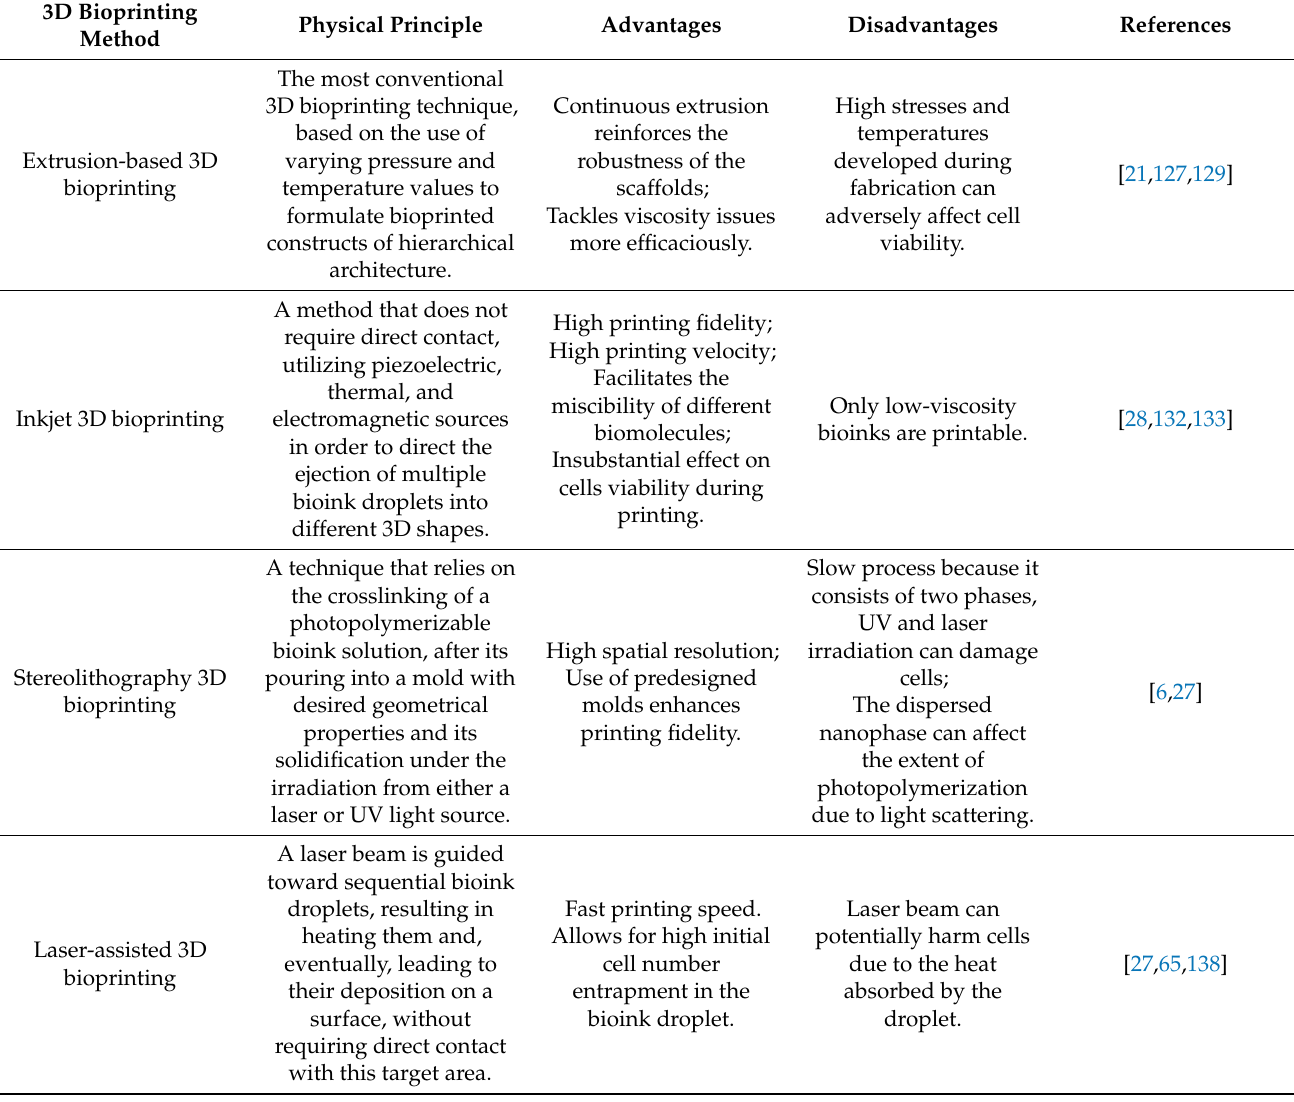
Table 1. A brief overview of the major bioprinting techniques with their advantages and